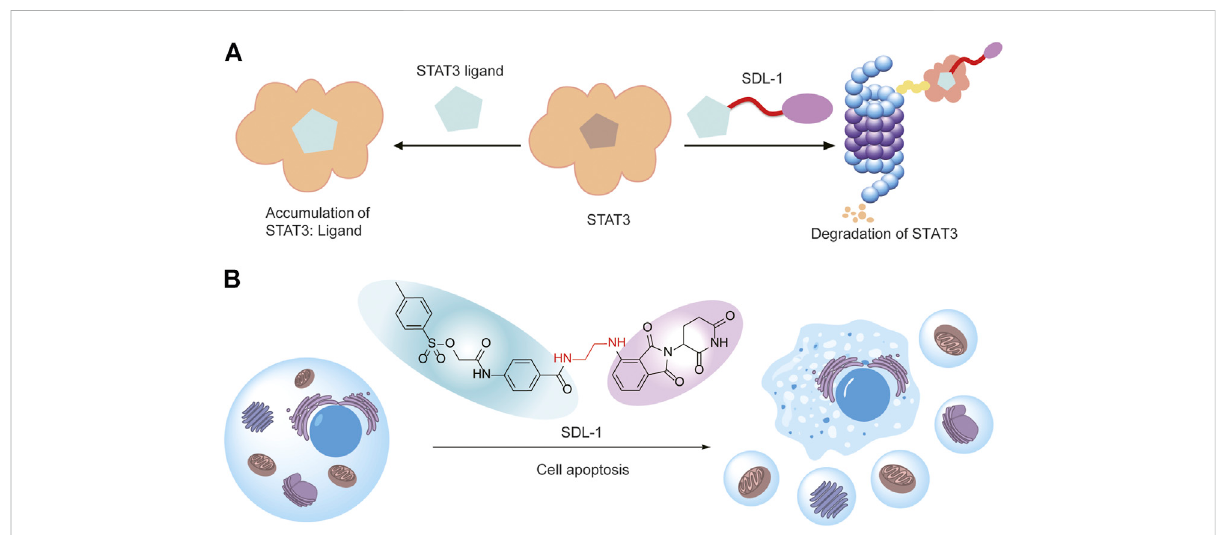
FIGURE 7 SDL-1 induces the formation of ternary complexes and leads to cell apoptosis. (A) The STAT3 ligand in SDL-1 binds to STAT3, and the E3 ubiquitin ligase ligand hijacks CRBN, transfers ubiquitinto STAT3 protein, and fi nally achieves ubiquitinationand degradation of the target